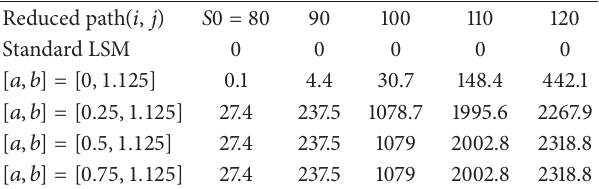
Table 7: Numerical result for Example 5.